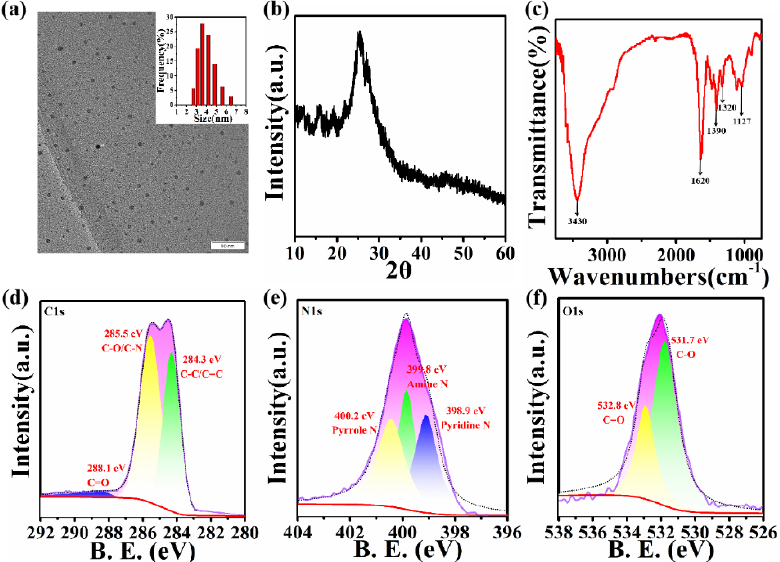
Figure 2. The TEM image and size distribution (inset) of R-CDs ( a ), XRD pattern ( b ), and FT-IR spectrum of R-CDs ( c ), high-resolution XPS spectrum of C1s ( d ), N1s ( e ), and O1s ( f ) of R-CDs.